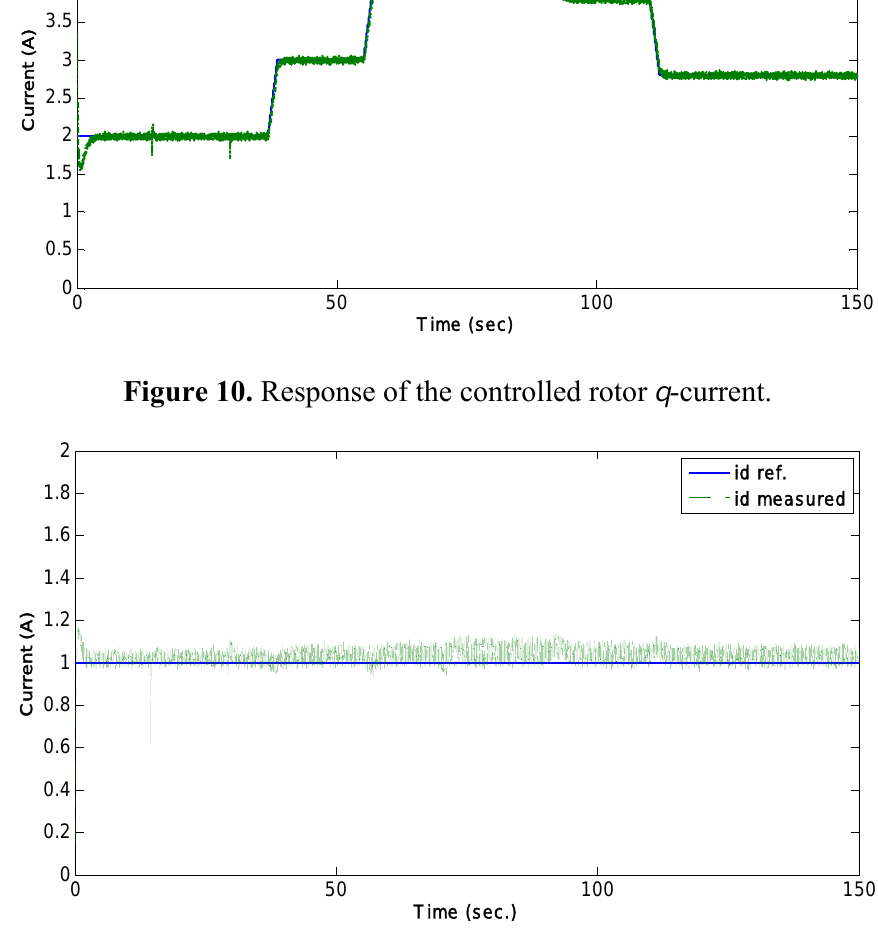
Figure 11. Response of the controlled rotor d